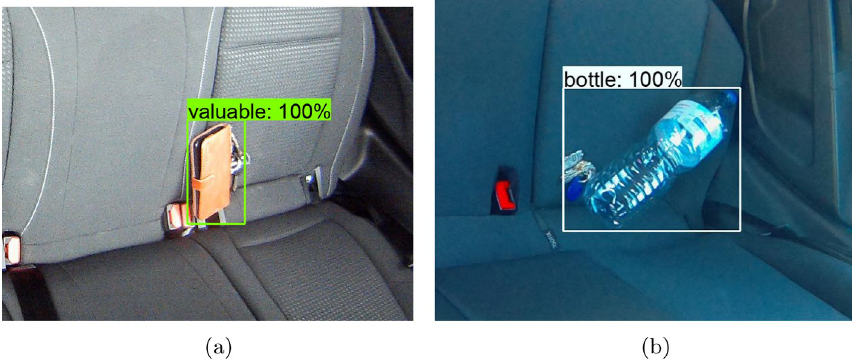
Fig. 26 False negatives of two predicted images in which key sets are left undetected due to overlapping